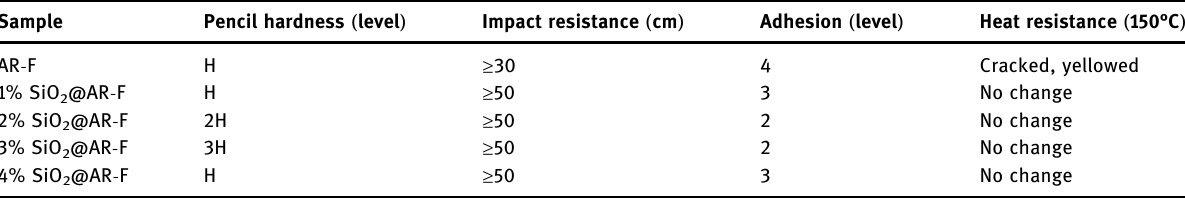
Table 4: Physical properties of coatings with di ff erent SiO 2 contents